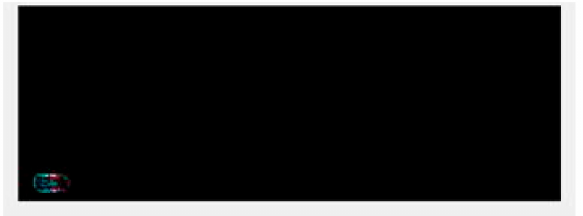
Figure 7. The obtained image when the Lucas Kanade pyramidal method was